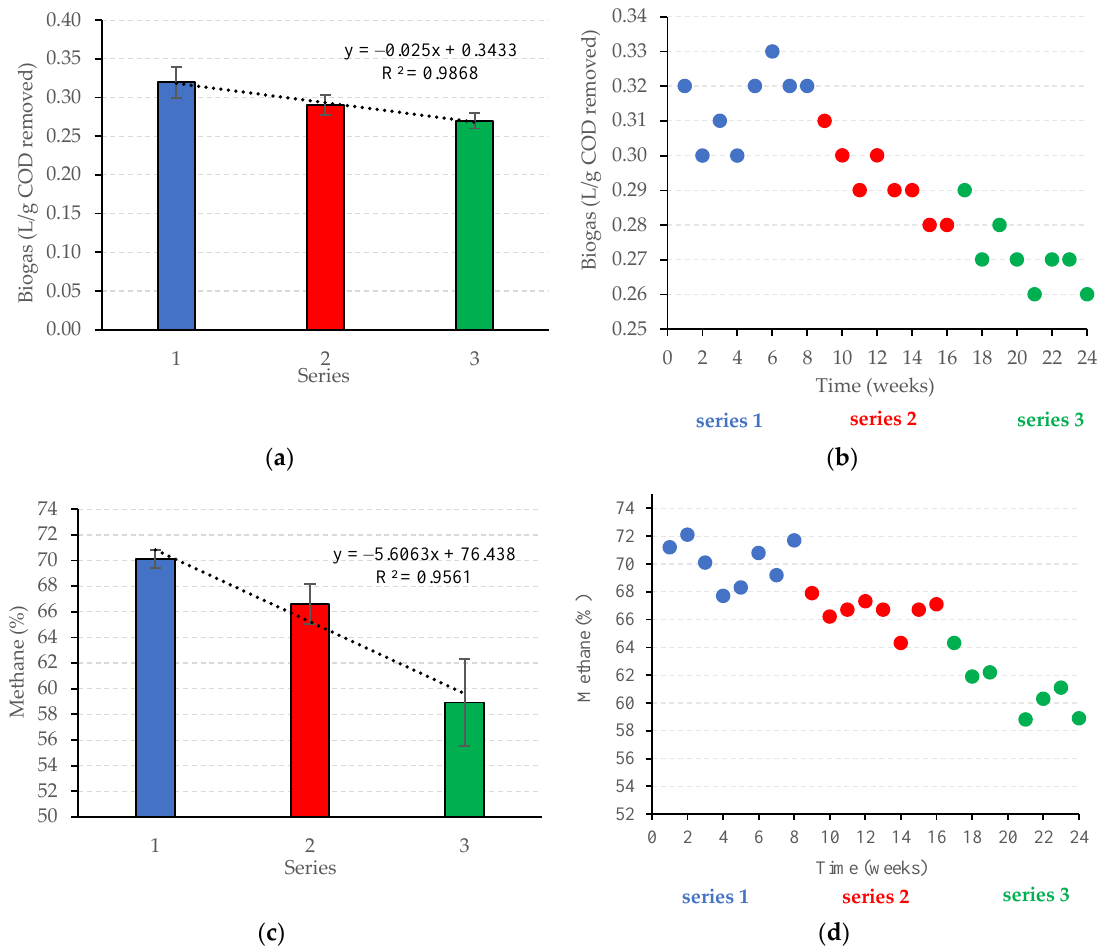
Figure 7. The efficiency of anaerobic confectionery wastewater treatment in stage 2: ( a ) average biogas production per g of COD removed with the standard deviation; ( b ) biogas production per g of COD removed during experimental time; ( c ) CH 4 concentration in biogas with the standard deviation; ( d ) CH 4 concentration in biogas during experimental time.